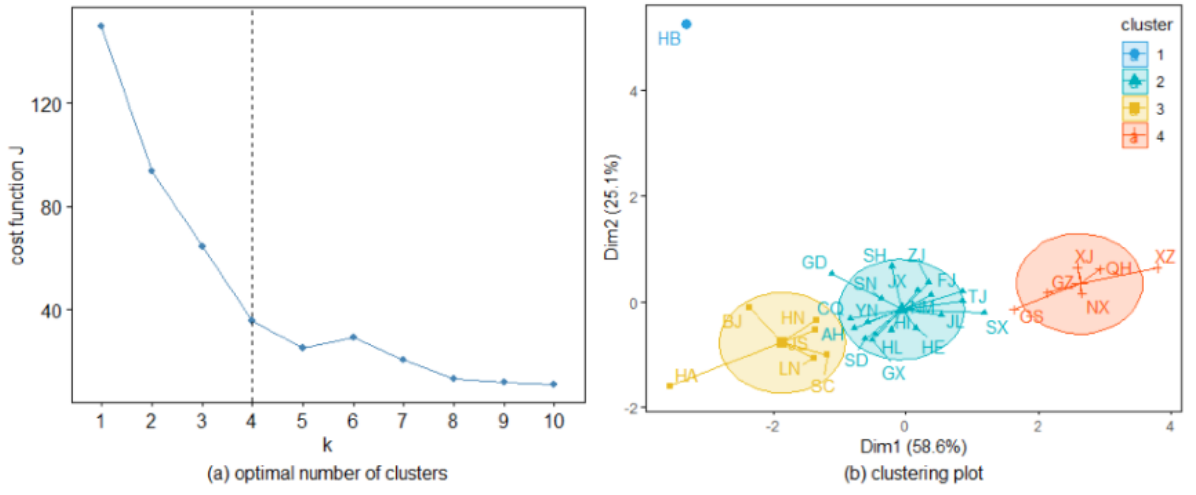
Figure 13. The optimal number of clusters and the clustering plot. The horizontal and vertical axes of the right panel represent the first and second principal components,